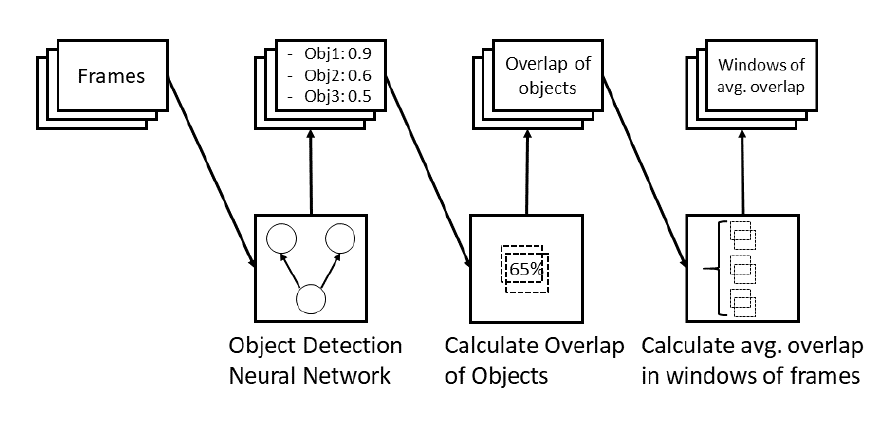
Figure 7. Pipeline for the image feature